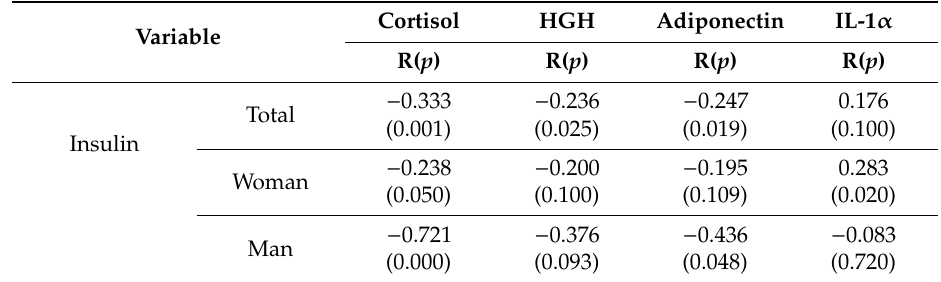
Table 3. The Spearman rank correlation analysis for C-reactive protein (CRP) and HGH, including selected variables in the general group, men and women. Resistin LH FSH GSSG TNF- α Variable R( p ) R( p ) R( p ) R( p ) R( p ) Total CRP (0.000) (0.664) (0.003) − 0.382 Man (0.088) (0.613) Resistin LH Variable 0.240 0.064 0.226 Total (0.023) (0.547) HGH